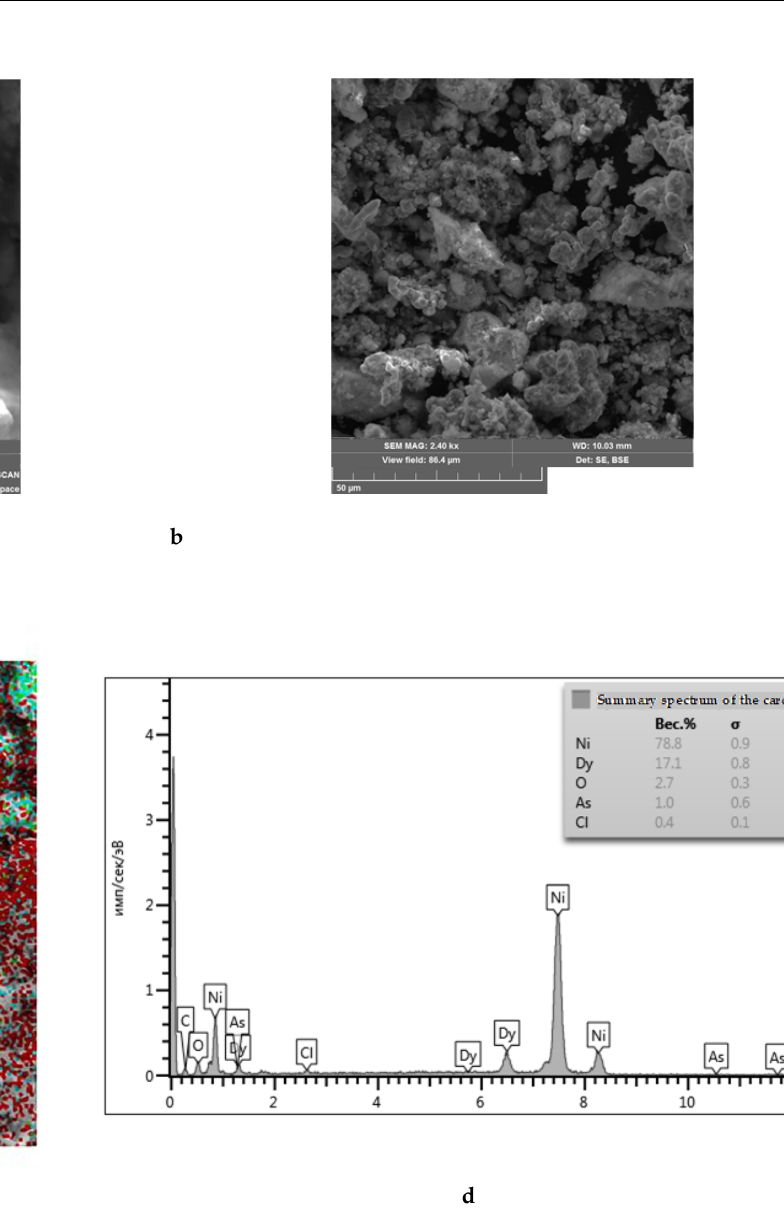
Figure 8. X-ray pattern ( a ), SEM images of the surface ( b ), color map of elemental distribution ( c ), and elemental analysis ( d ) of the cathode deposit obtained by electrolysis of the KCl-NaCl-DyCl 3 -NiCl 2 melt at 973 K for 2 h, at the voltage of 3.4 V, and electrolysis potential of − 1.6 V vs. Ag/AgCl. Concentration of DyCl 3 is 3.0 × 10 − 4 mol/cm 3 . Concentration of NiCl 2 is 0.5 × 10 − 4 mol/cm 3 .